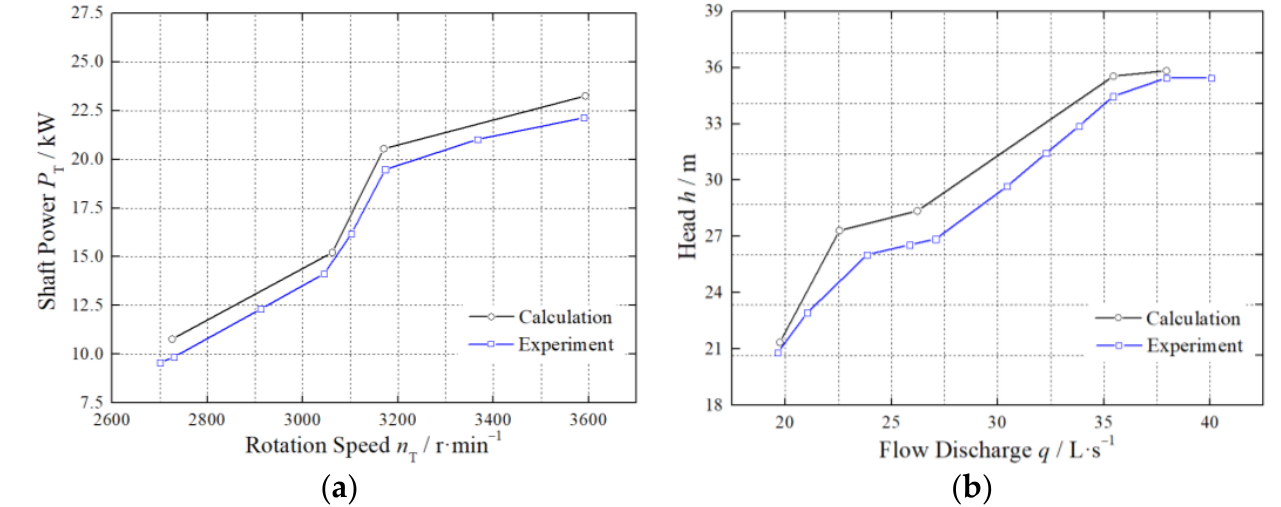
Figure 6. Comparison between experiment result and numerical simulation. ( a ) Turbine speed characteristic curves. ( b ) Pump performance characteristic curves.